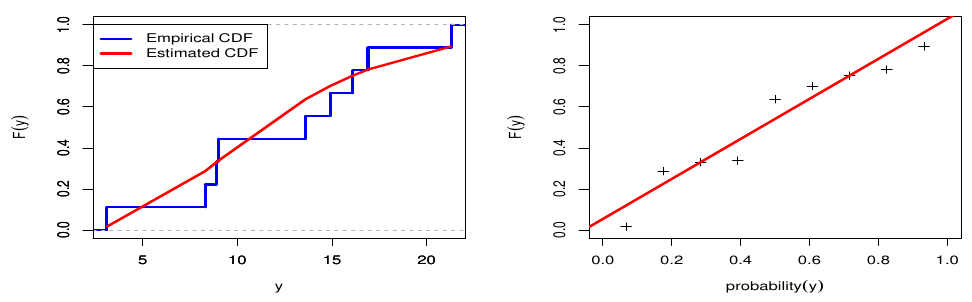
Figure 5. Empirical CDF and P-P plots for the EED for dataset 2.